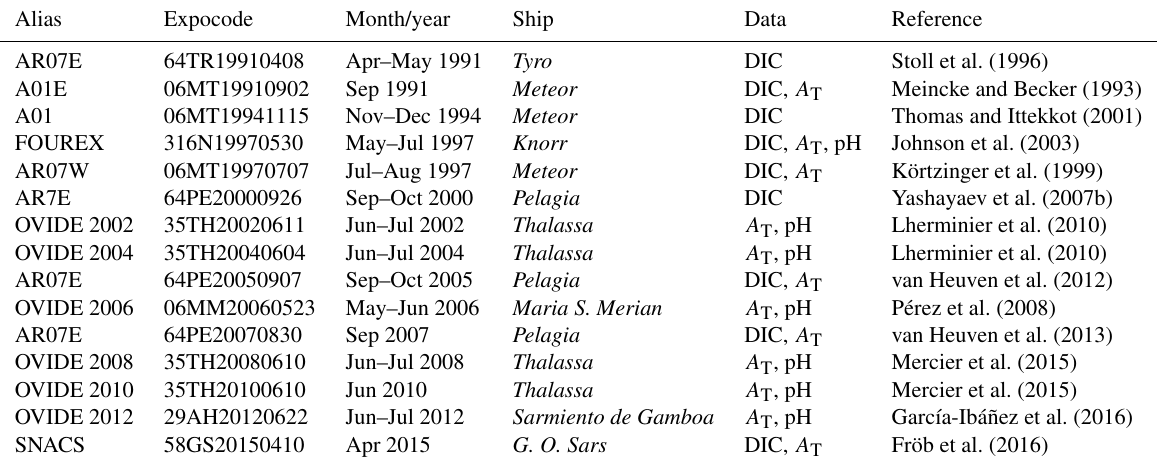
Table 1. Irminger Sea cruise information. The measured variables of the seawater CO 2 chemistry are indicated. Alias Expocode Month/year Ship